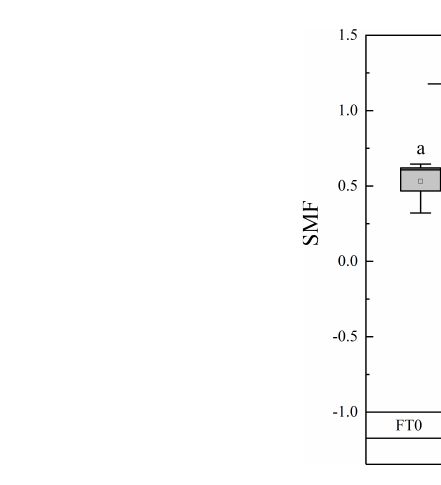
FIGURE 4 Effect of FTC on soil nutrient multifunctionality in different soil layers. Results are mean ± SE of fi ve independent replicates. Different lowercase and uppercase letters indicate signi fi cant differences between the FTC treatments (P < 0.05), **(P <